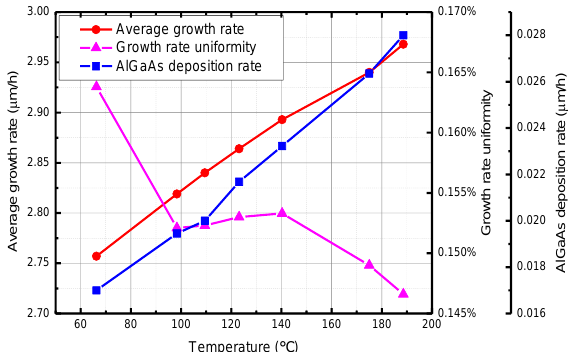
Figure 7. Simulated results of average growth rate, growth rate uniformity, and AlGaAs deposition rates as functions of ceiling temperature; the AlGaAs deposition rates and ceiling temperature were measured at a radial position of 210 mm from the chamber center. P = 5 × 10 3 Pa, T growth = 700 ◦ C, carrier gas flow rate Q H2 = 37 slm, total AsH 3 flow rate Q AsH3 = 600 sccm.